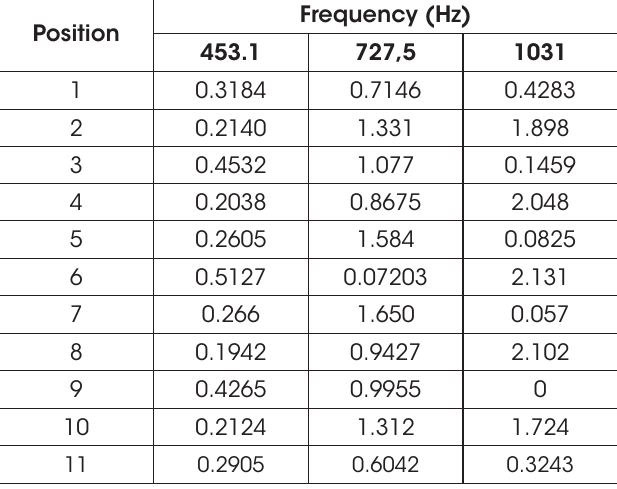
Peak values of the FRFs in the eleven